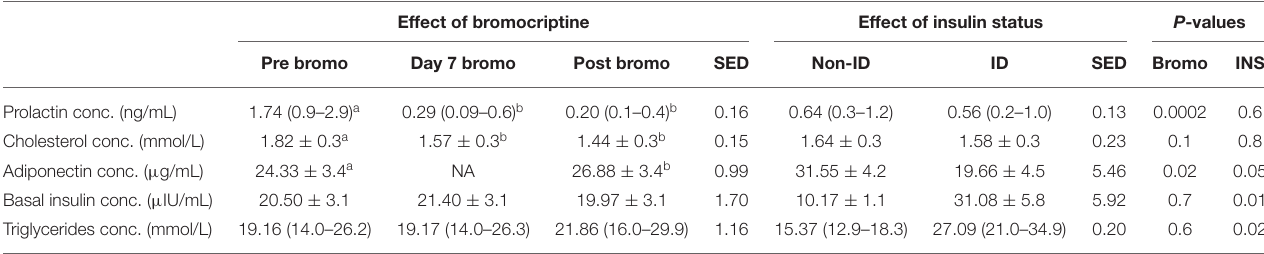
TABLE 6 | Effect of bromocriptine and insulin status on plasma